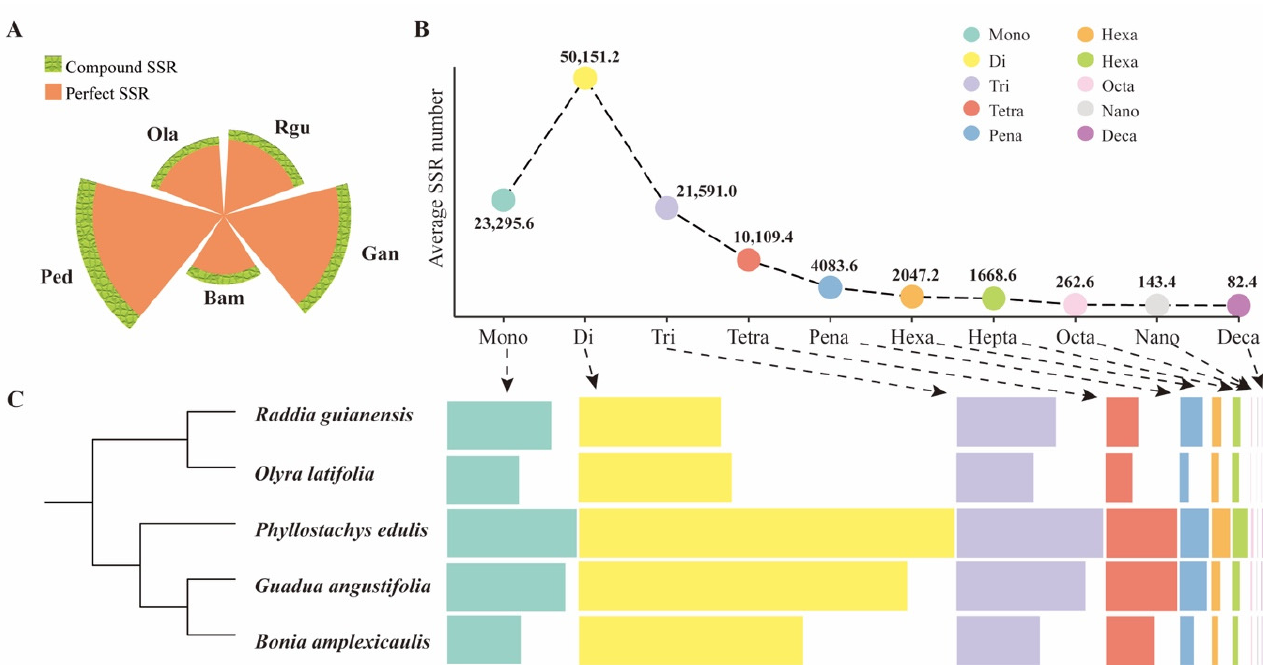
Figure 1. Comparison of the distribution of different SSR types in five bamboo species of B. amplexicaulis (Bam), G. angustifolia (Gan), P. edulis (Ped), O. latifolia (Ola), and R. guianensis (Rgu). ( A ) The distribution of perfect SSRs and compound SSRs in different bamboo species. ( B ) The average number of ten SSR types (mono- to decanucleotides) in five bamboo species. ( C ) The boxplots indicating the SSR number of each type in different species.